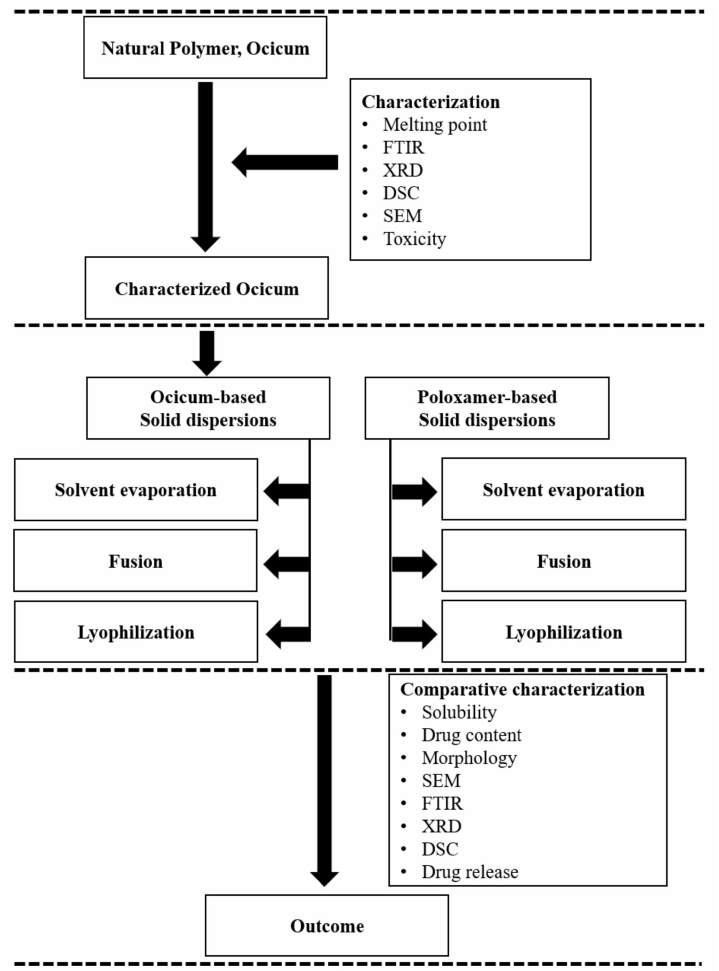
Figure 7. Schematics for study